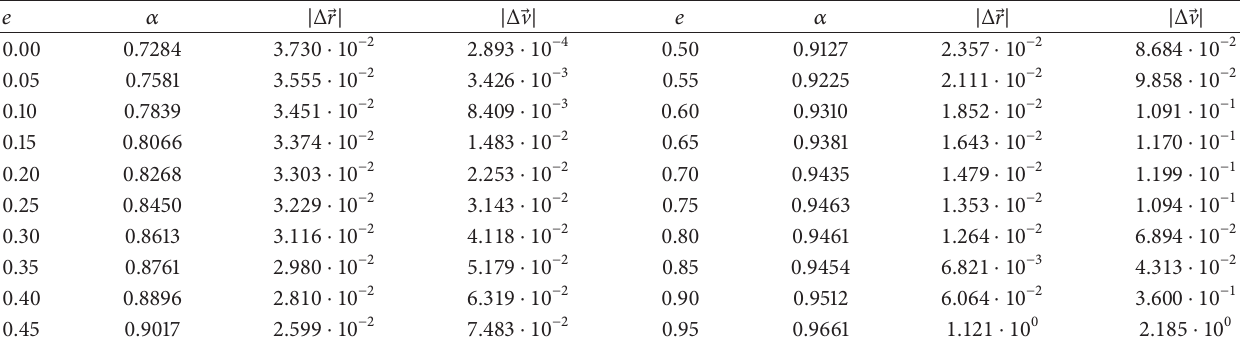
Table 2: Optimal 𝛼 for 𝑒|Δ ⃗𝑟| in 10 −5 Km |Δ ⃗ V | in 10 −8 Km/s.